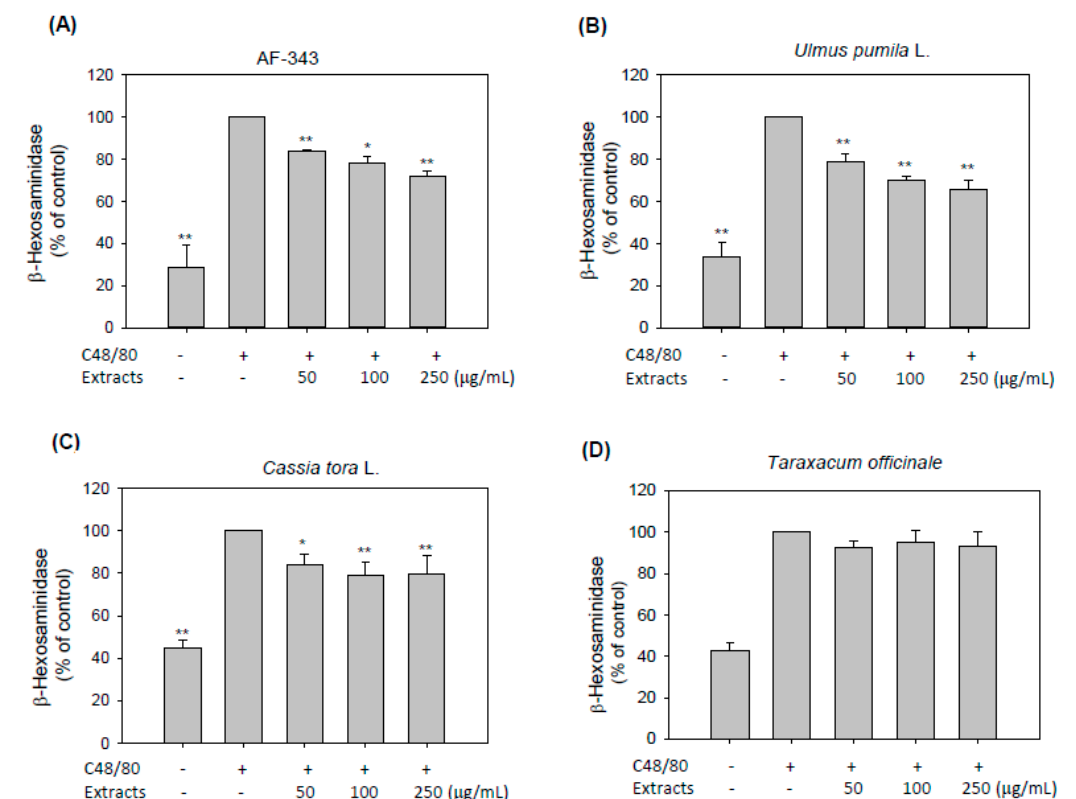
Figure 2. Inhibitory effects of AF-343 and extracts of Ulmus pumila L., Cassia tora L., and Taraxacum officinale on β -hexosaminidase release in RBL-2H3 cells. ( A – D ) RBL-2H3 cells were pretreated with the test samples for 1 h following stimulation with compound 48/80 for 1 h. β -hexosaminidase release was detected in the cell culture supernatants. The results are expressed as the mean ± SD from three independent experiments. * p < 0.05 and ** p < 0.01 vs. the compound 48/80 only group. C48/80, compound 48/80.